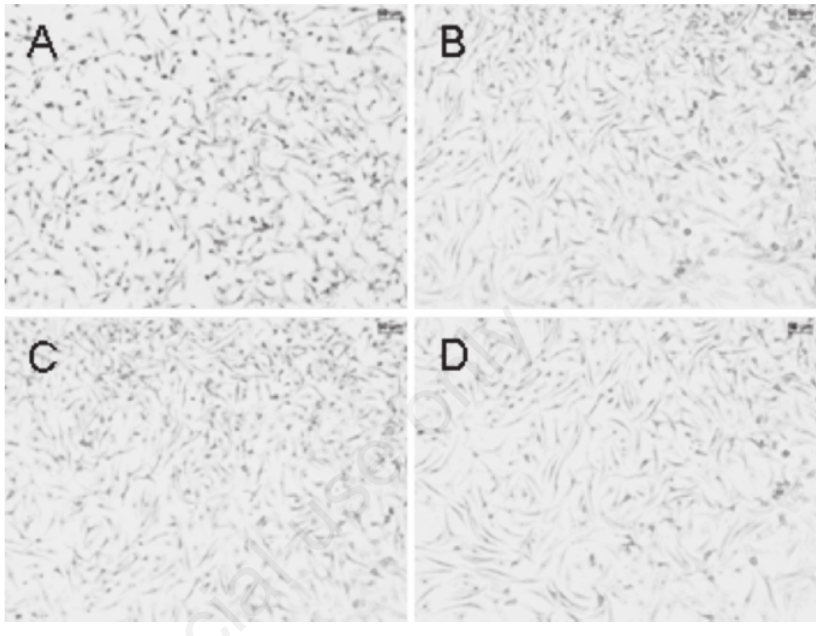
Figure 1. Light microscopy images showing the morphology of Haliotis tuberculata hemocytes. Cells were seeded at a density of 5×105 cells per well and grown at 17°C in culture medium for 48 h in the absence (A) or presence of 500 µg/L of venlafaxine (B), gabapentine (C) and cetirizine (D).